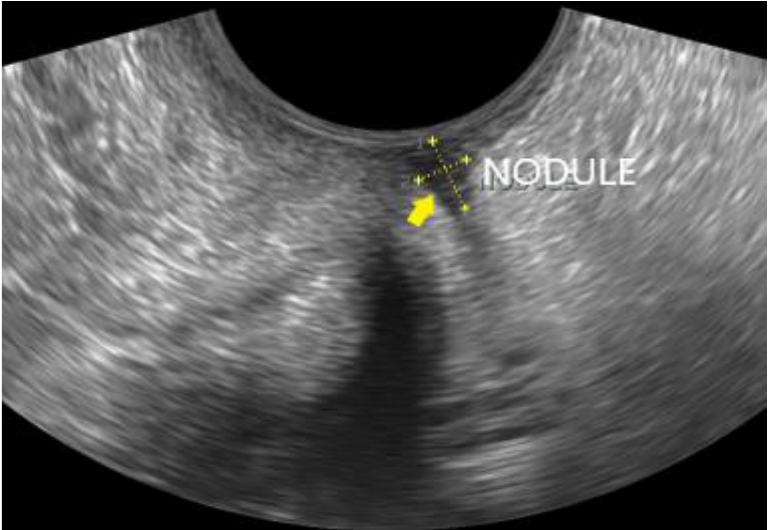
Figure 11. A small DIE nodule of the rectovaginal septum (yellow arrow), appearing as a hy- poechoic lesion with no infiltration of the adjacent vaginal or rectal wall.